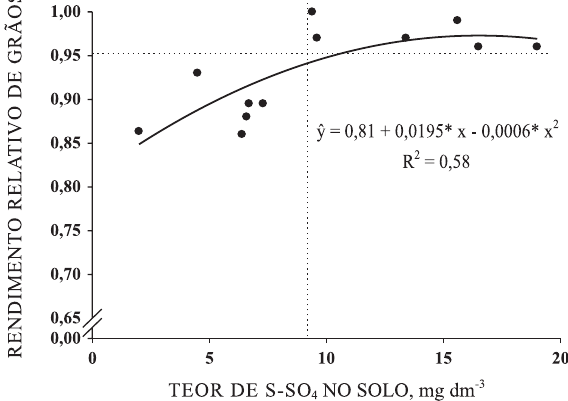
Figura 3. Curva de calibração de enxofre de solos da região da Depressão Central do RS. Safras 2004/ 2005 e 2005/2006. *: significativo pelo teste F (p <